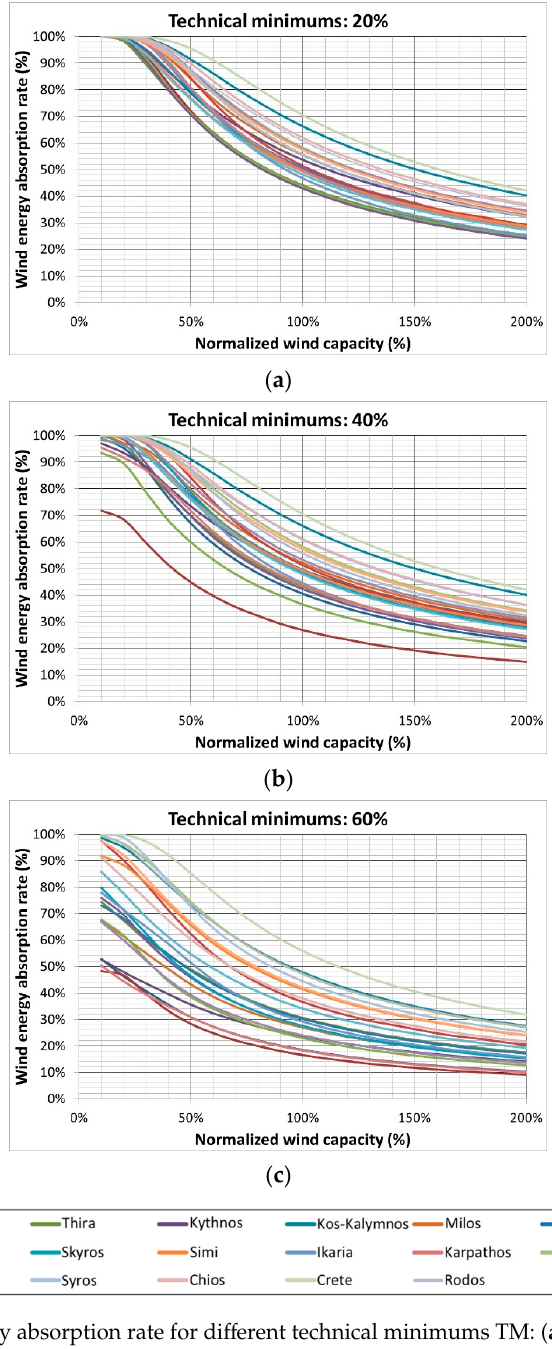
Figure 16. Wind energy absorption rate for different technical minimums TM: ( a ) 20%, ( b ) 40%, ( c ) 60% (without PV capacity).